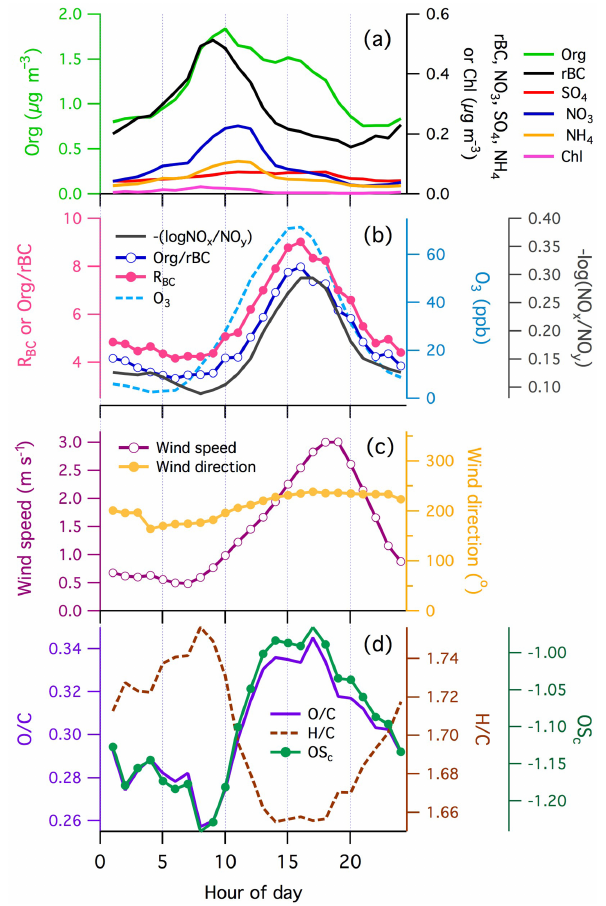
Figure 2. Diurnal cycles of (a) rBC and NR-PM rBC , (b) the Org / rBC ratio, R BC , ozone and − log (NO x / NO y ) , (c) wind speed and direction, and (d) O / C, H / C, and OS within the hot period (See Fig. S7 in the Supplement for the uncertainties of